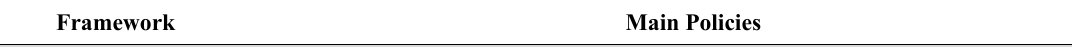
Summaries of entrepreneurship policies